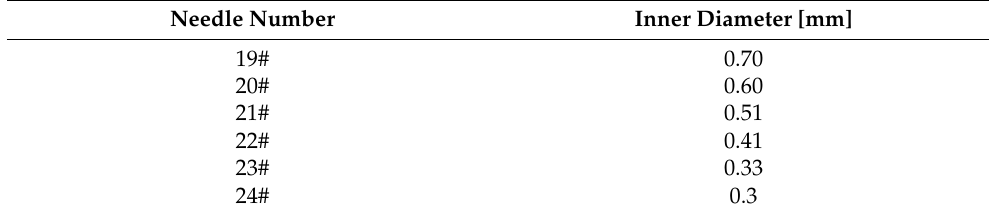
Table 1. The diameter of